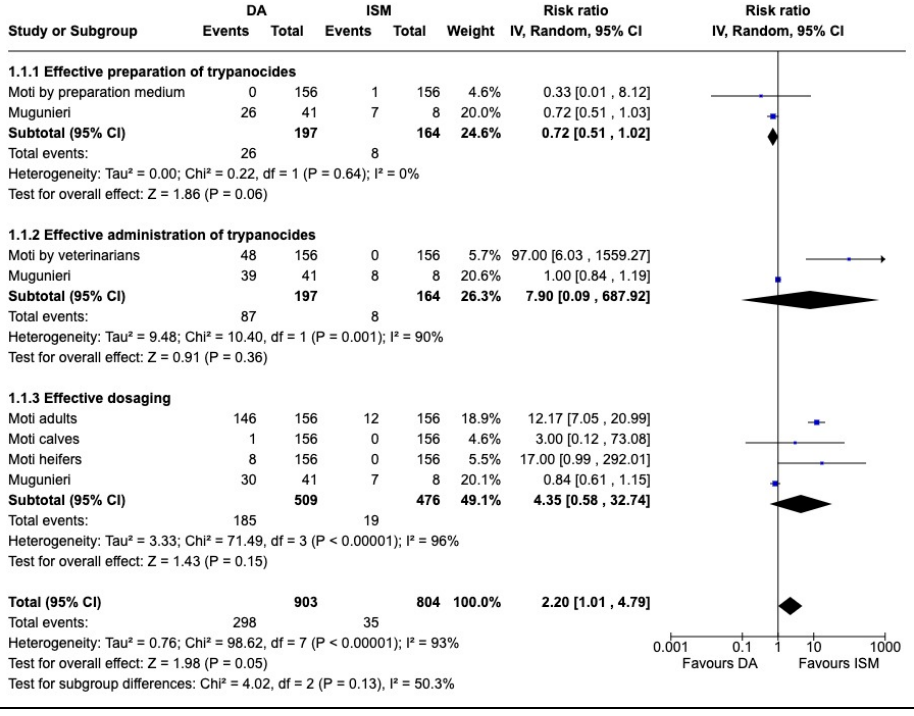
Figure 2. Meta-analysis of community practices responsible for the development of African trypa- nocide resistance.